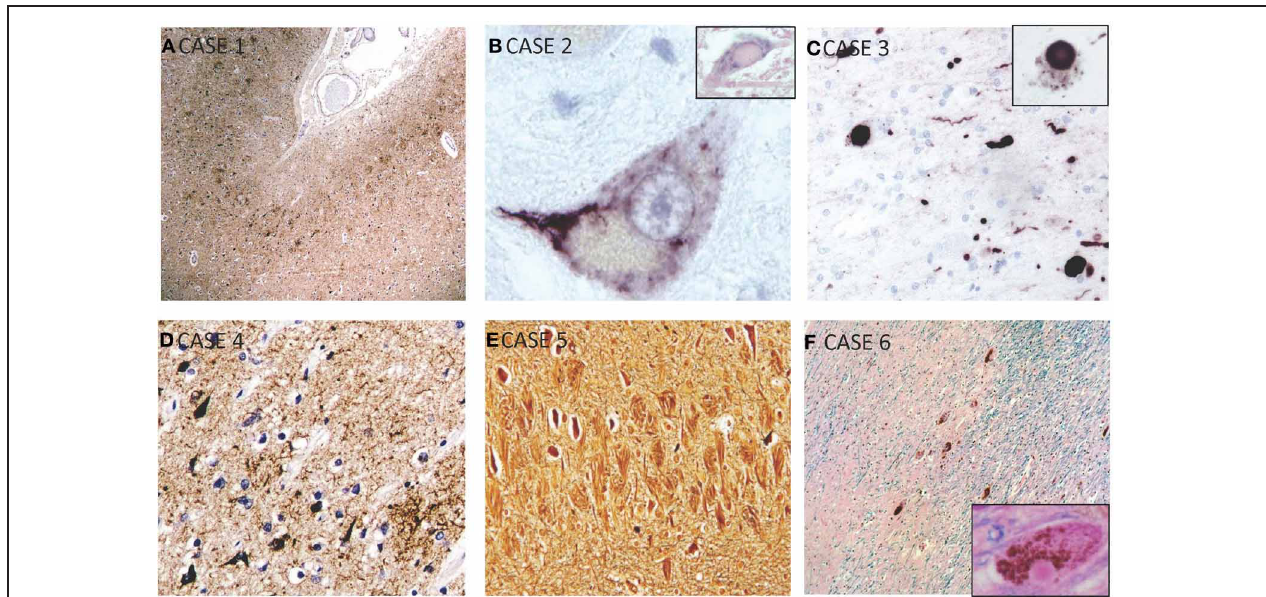
cortex, substantia nigra, and locus ceruleus. This patient also had features of CTE (not shown). Inset shows higher power view of cytoplasmic Lewy body. (D) Case 4: Immunohistochemisty showing widespread reactivity against tau-positive neurofibrillary and astrocytic tangles in multiple layers. (E) Case 5: Bielschowsky silver stain showing numerous neurofibrillary tombstones in the hippocampus. (F) Case 6: HandE/LFB and alpha-synuclein staining of representative cortical section showing diffuse Lewy bodies and Lewy neurites. Inset shows Lewy